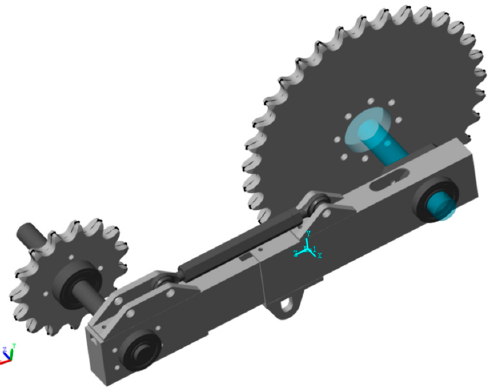
Figure 8. Track frame connecting the sprocket shaft (in blue) and the idler shaft.